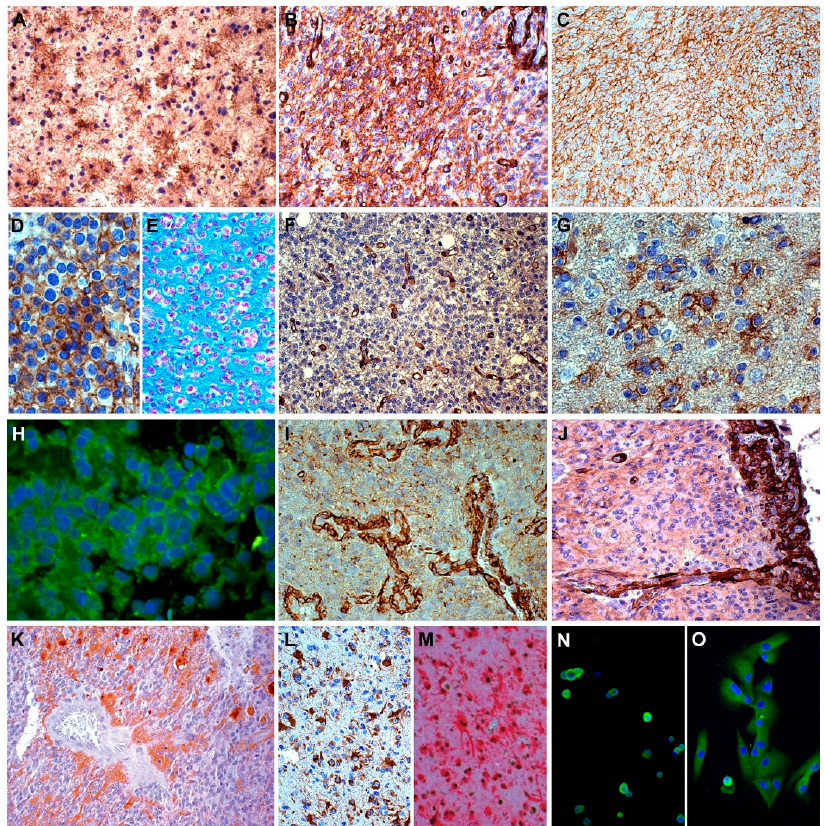
Figure 4. NG2/CSPG4 immunohistochemistry. ( A ) World Health Organization (WHO) grade II astrocytoma. Negative tumor cells and NG2/CSPG4-positive reactive astrocytes; DAB, 400×. ( B ) IDH-